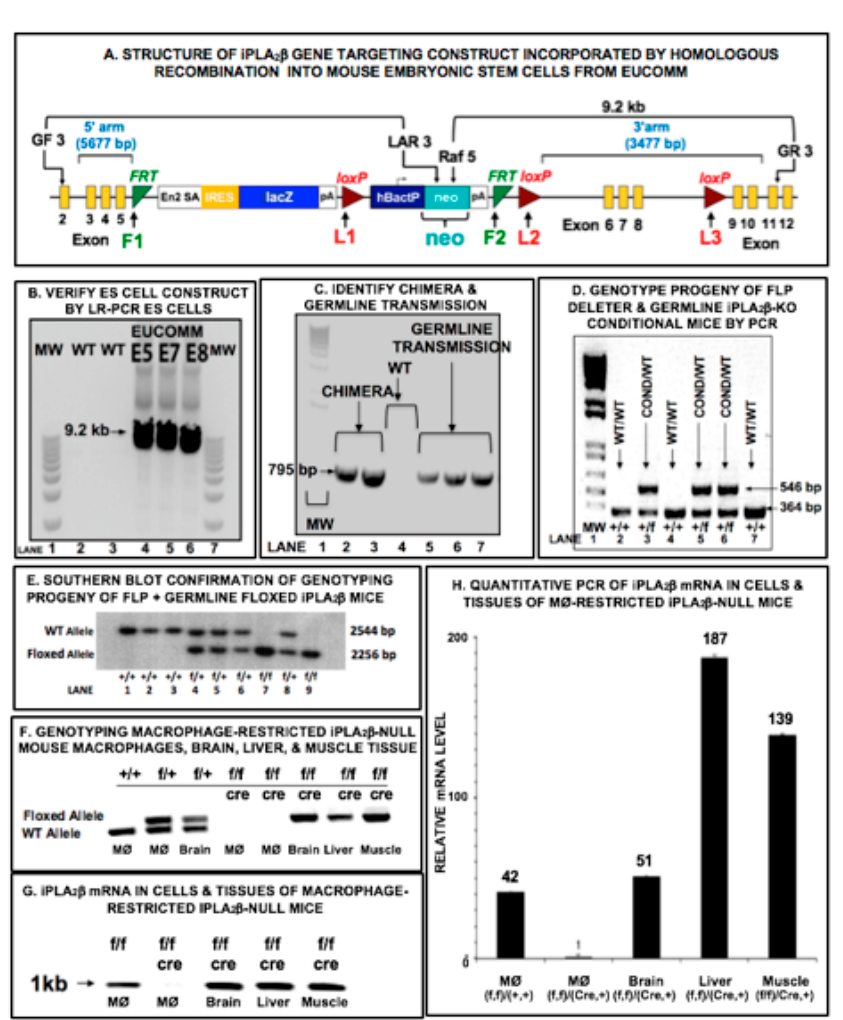
Figure 1. Cre-Lox Preparation of Mutant Mice with Tissue-Restricted Deletion of iPLA 2 β . ( A ) is a schematic illustration of the structure of the gene-targeting construct that was incorporated by homologous recombination into mouse embryonic stem (ES) cells from European Conditional Mouse Mutagenesis (EUCOMM). ( B ) demonstrates correct integration of the 5’ and 3’ arms of the construct in the ES cell lines by long-range PCR using primer sets that recognize sequences external to the construct and within the neo cassette, respectively, to yield a 9.2 kb product. ( C ) illustrates that injection of the ES cells into blastocysts that were then implanted into pseudo-pregnant female mice resulted in production of chimeric mice with germline transmission of the targeted gene to yield heterozygotes for the wild-type (WT) and EUCOMM iPLA 2 β alleles. ( D ) illustrates that mating of these heterozygotes with FLP deleter mice resulted in removal of the region between F1 and F2 sites in the targeting construct that contained the neo cassette to yield an iPLA 2 β allele that contained Lox2 and Lox3 sites flanking iPLA 2 β exons 6–8 and that this allele is distinguishable from the WT allele upon PCR analyses. ( E ) is a Southern blot of gene fragments after Bam H1 endonuclease digestion and illustrates production of fragments characteristic of the WT and conditional alleles that establish the genotype of individual mice. WT and conditional iPLA 2 β heterozygotes were mated to yield conditional allele homozygotes, heterozygotes, and WT allele homozygotes in a 1:2:1 ratio. Those mice were then mated with mice that express Cre recombinase under control of LysM or RIP2 promoters to drive Cre expression selectively in macrophages or pancreatic islet β -cells, respectively. ( F ) illustrates that with conditional allele homozygotes these matings result in selective iPLA 2 β deletion in only the targeted cell line and not in other tissues. ( G , H ) illustrate that iPLA 2 β mRNA is not produced in the Cre-expressing cell type in mice that are iPLA 2 β conditional allele homozygotes but that iPLA 2 β mRNA is produced by non-targeted